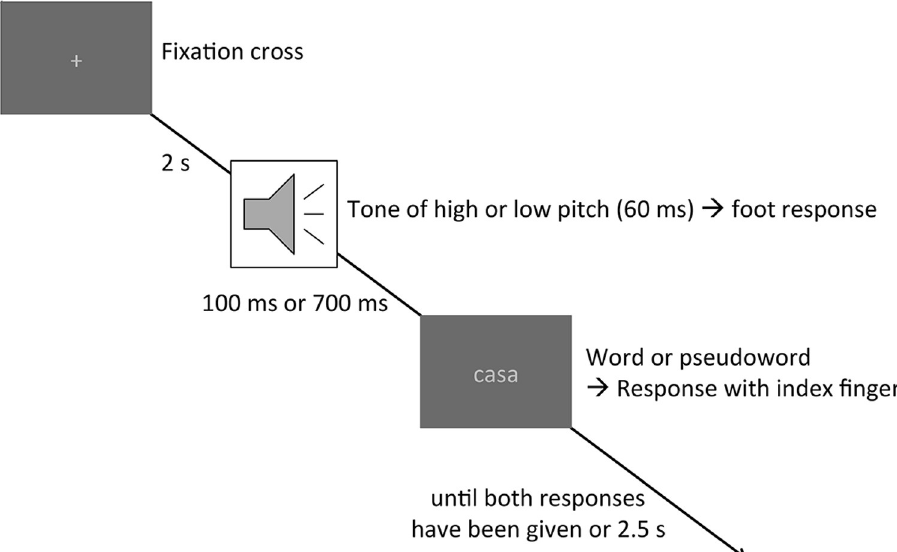
Fig 7. Trial scheme. A trial started with a fixation cross. After 2 s, a tone of 60 ms duration and either high or low pitch was presented, requiring a pitch discrimination via a foot response (task 1). After a stimulus onset asynchrony (SOA) of either 100 or 700 ms, a letter string (either a word or a pseudoword) replaced the fixation cross on the screen, requiring a lexical decision via button press with the left or right index finger (Task 2). The letter string remained on the screen until both responses had been given for a maximum of 2.5